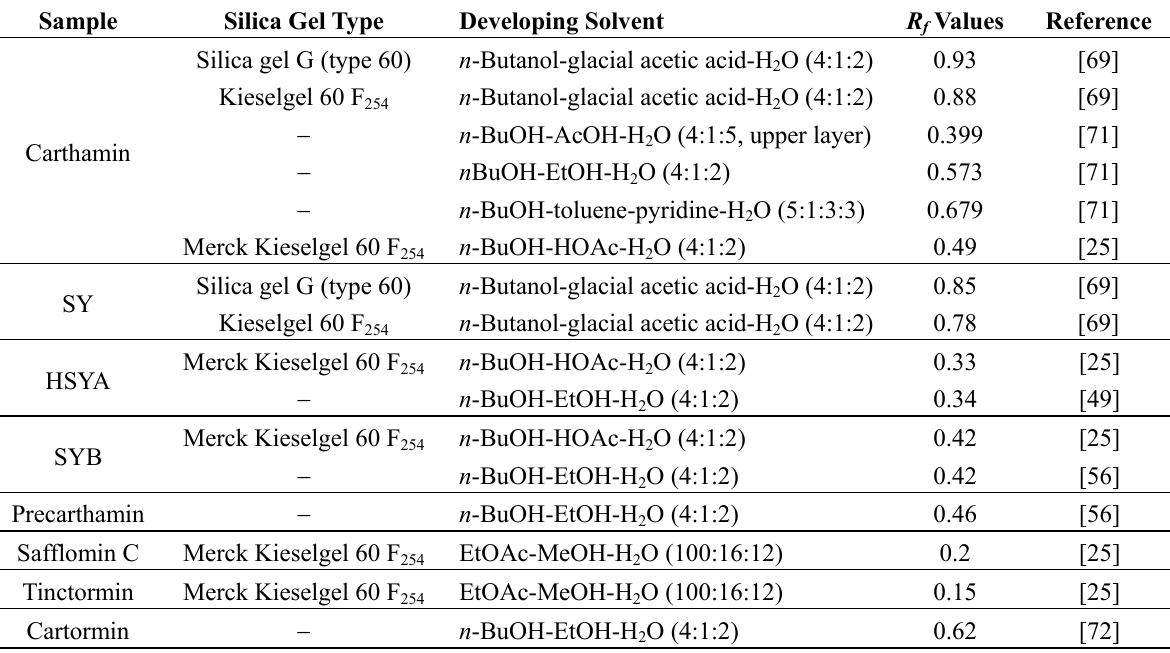
values of quinochalcone C Table 5. The R f